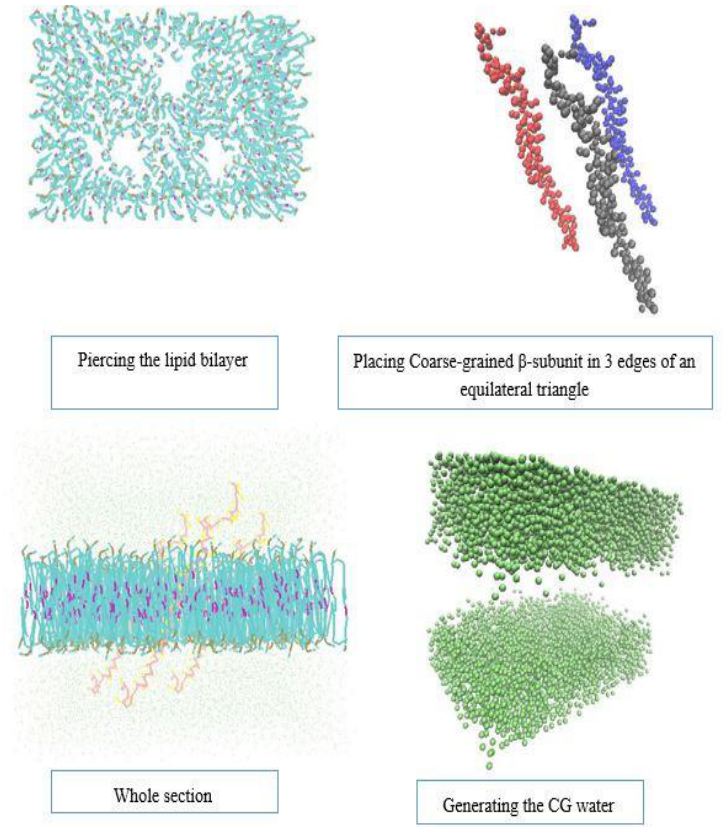
Figure 8. Preparation of the β-subunit CG simulation.